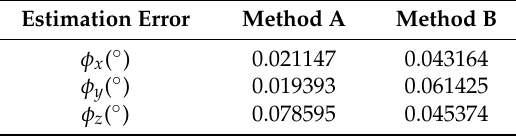
Table 3. The RMSE of attitude